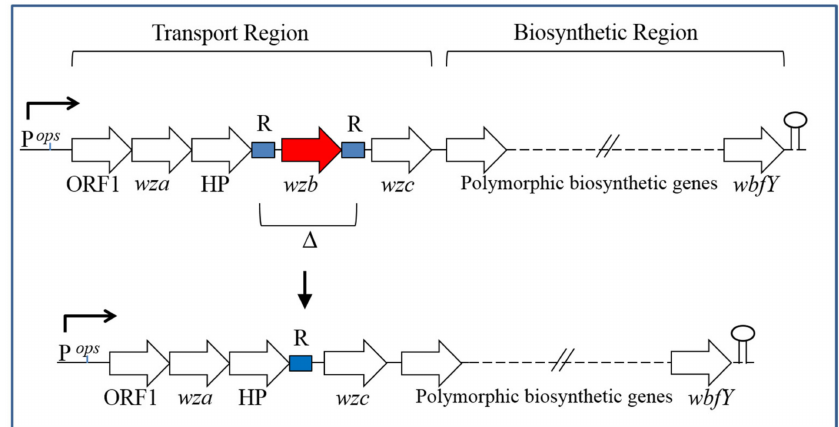
Figure 2. Model for generation of phase-locked translucent variants based on Chatzidaki-Livanis et al. (2006). The upper portion of the figure depicts the general organization of the Group 1 CPS operon in V. vulnificus , including the positions of the essential wzb phosphatase gene and repeat sequence (R) regions flanking that gene. For strains containing allele 1 of this operon, each R region contains multiple copies of the octamer (ACAGGACC). Allele 2 strains have an additional R region (not shown) located between wza and HP (hypothetical protein gene), and each R region contains multiple copies of (A / CCTAGG / AAA / C) [32]. Starting with an opaque variant, homologous recombination between R regions with deletion of intervening sequences, including wzb , would generate a phase-locked translucent variant (i.e., as depicted in the lower portion of the figure) [32]. The relative positions of the operon promoter (P), ops element, and Rho-independent transcription terminator hairpin structure are